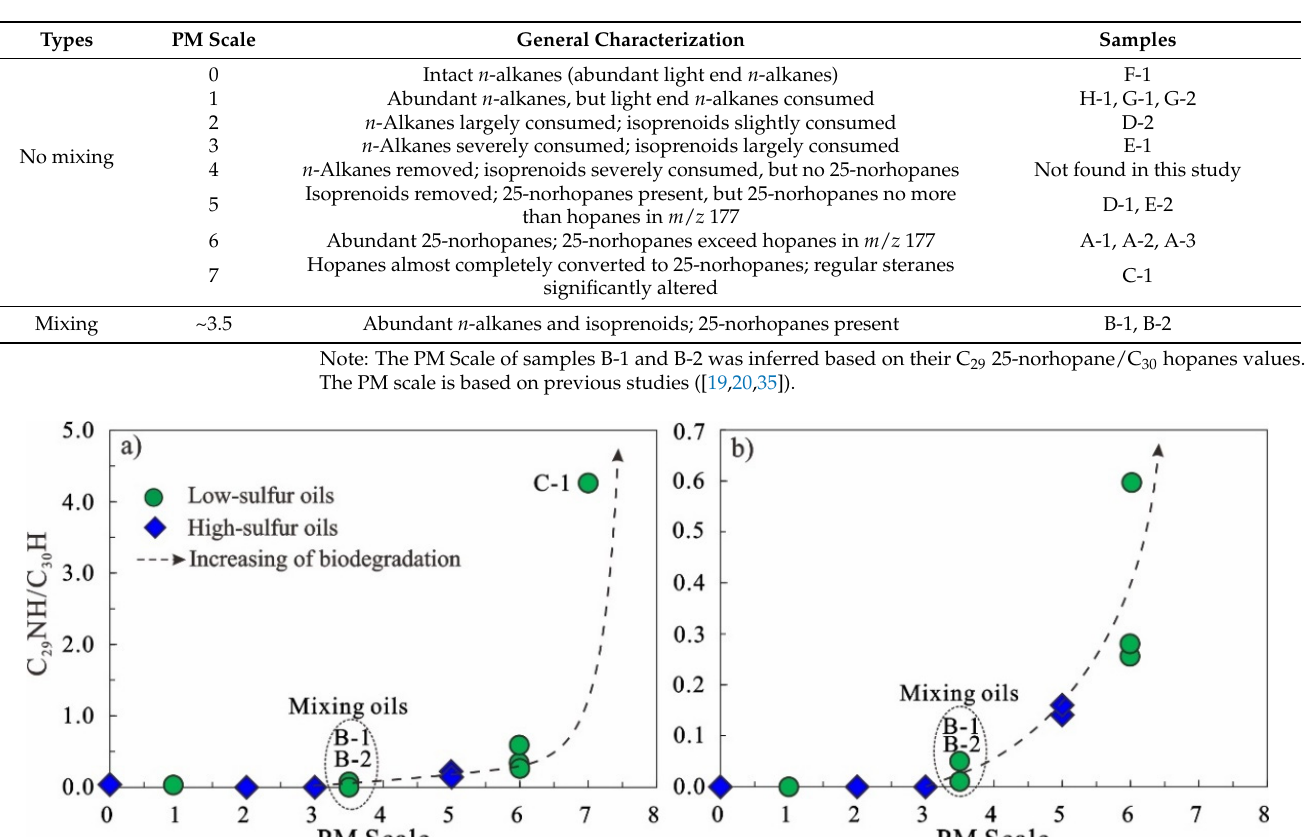
Table 4. General characterization of saturated fractions of oil samples with different biodegradation levels (PM Scale).